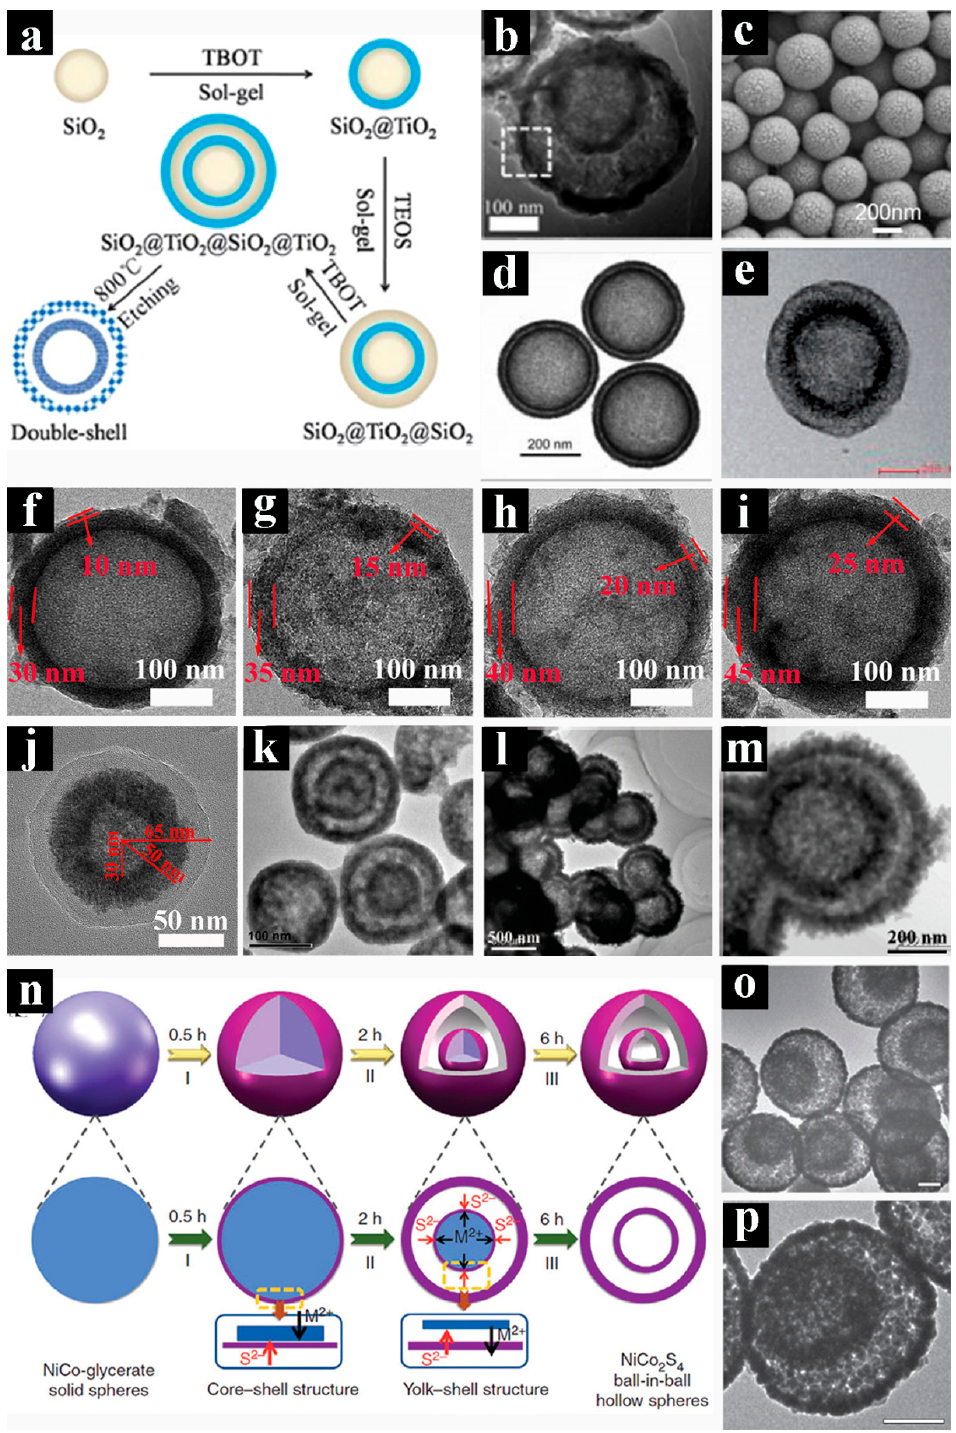
Figure 6. Schematic demonstration and graphical illustration of double–shell structure: ( a ) Scheme of fabrication of the titanium dioxide (TiO 2 ) double-shelled hollow spheres (DSHSs), and ( b ) magnified transmission electron microscopy (TEM) image of a single TiO 2 DSHS. ( c ) field-emission SEM (FESEM) image and ( d ) TEM image of the SnO 2 @C DSHSs. ( e ) TEM image of a single DHCS-S nanosphere. ( f , g , h and i ) TEM images of the TiO 2 /NiO DSHSs with the different weight of NiO. ( j ) TEM image of CeO 2 @C DSHSs. ( k ) TEM image of the Cu 2 O DSHSs. ( l ) Low-magnification TEM image and ( m ) HRTEM image of the V 2 O 5 − SnO 2 DSHSs. ( n ) Schematic illustration of the fabrication of the NiCo 2 S 4 DSHSs, ( o and p ) TEM images of the NiCo 2 S 4 DSHSs. Pictures ( a ) and ( b ) were reprinted with permission from Reference [112]. Copyright the Royal Society Chemistry, 2015. Pictures ( c ) and ( d ) were reprinted with permission from Reference [113]. Copyright Wiley, 2009. Picture ( e ) was